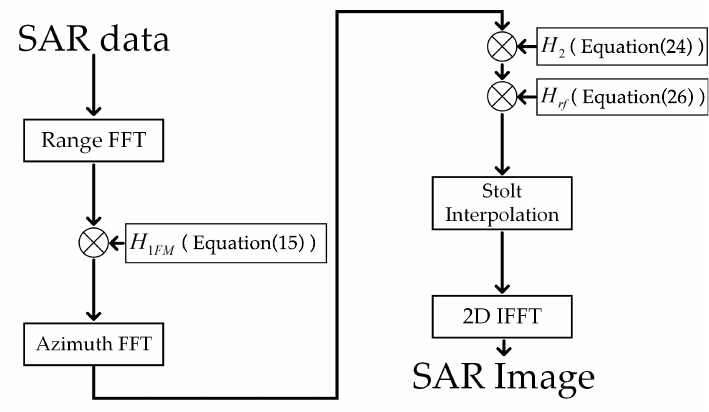
Figure 4. Flowchart of modified